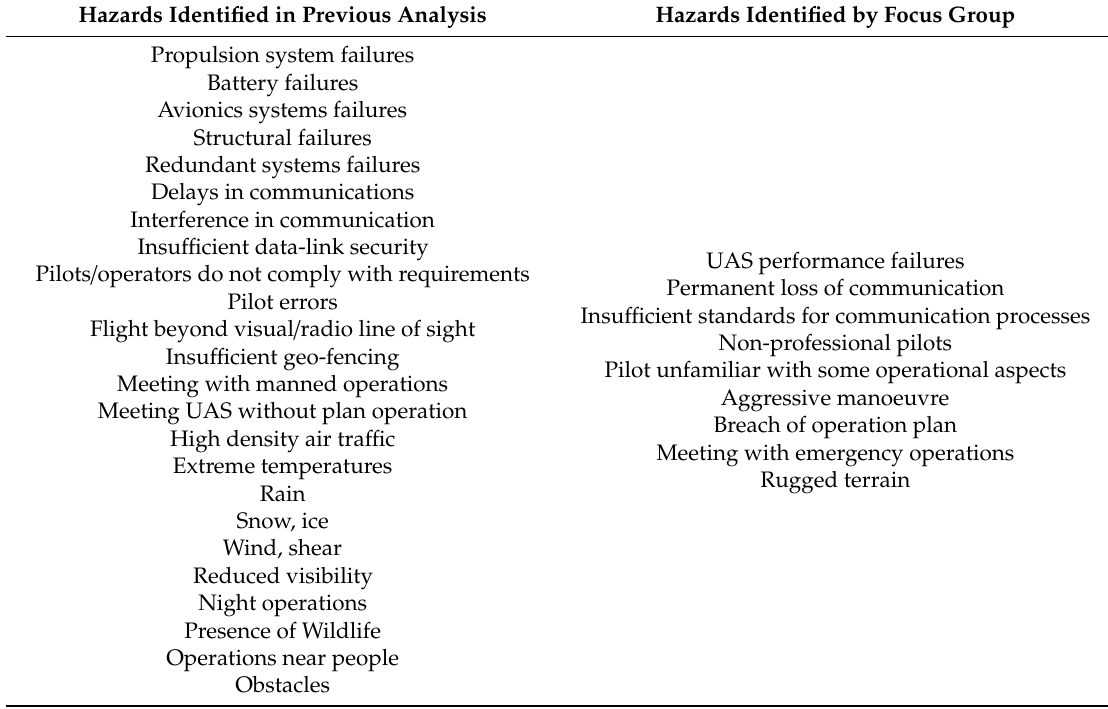
Table 2. Hazards identified during risk